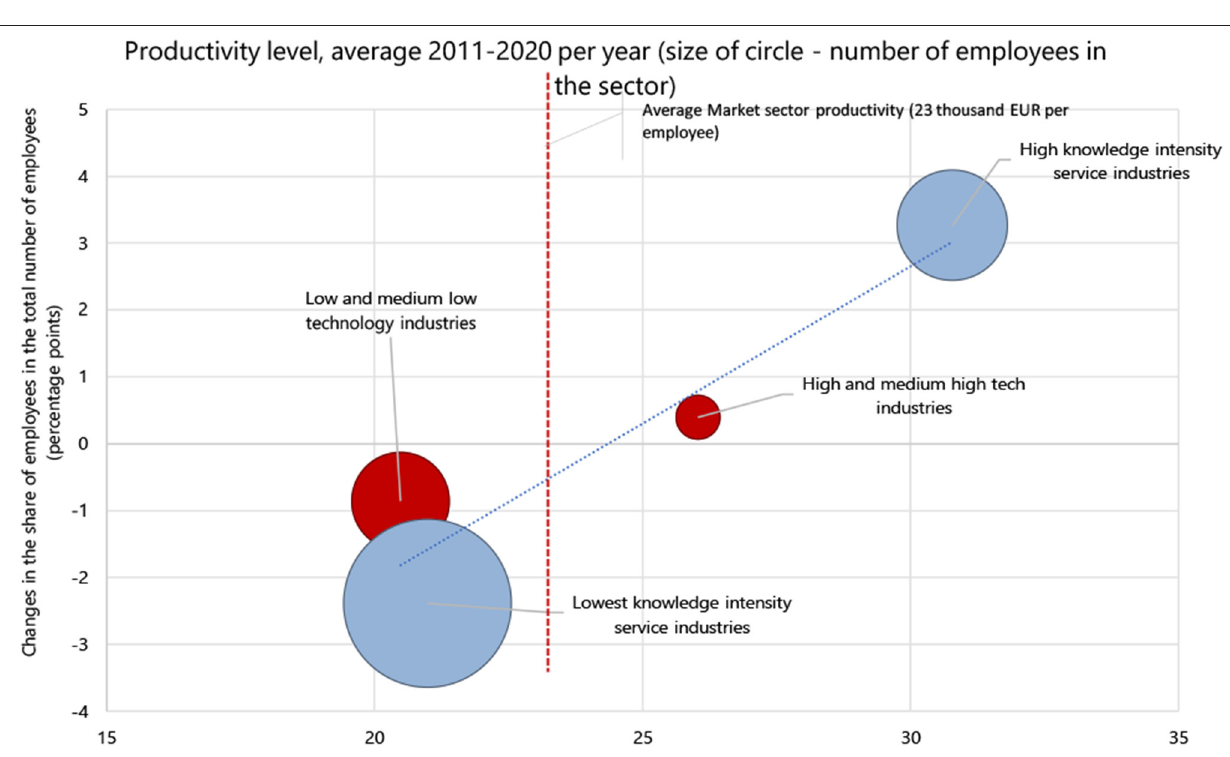
Frontiers in Public Health |